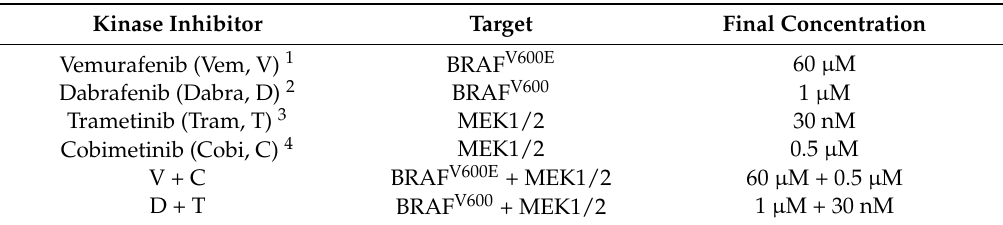
Table 1. Concentrations of kinase inhibitors used either alone or in combination in in vitro experiments (see materials and methods for more details). Kinase Inhibitor Target Final Concentration Vemurafenib (Vem, V) 1 BRAF V600E 60 µ M Dabrafenib (Dabra, D) 2 BRAF V600 1 µ M MEK1/2 30 nM Cobimetinib (Cobi, C) 4 MEK1/2 0.5 µ